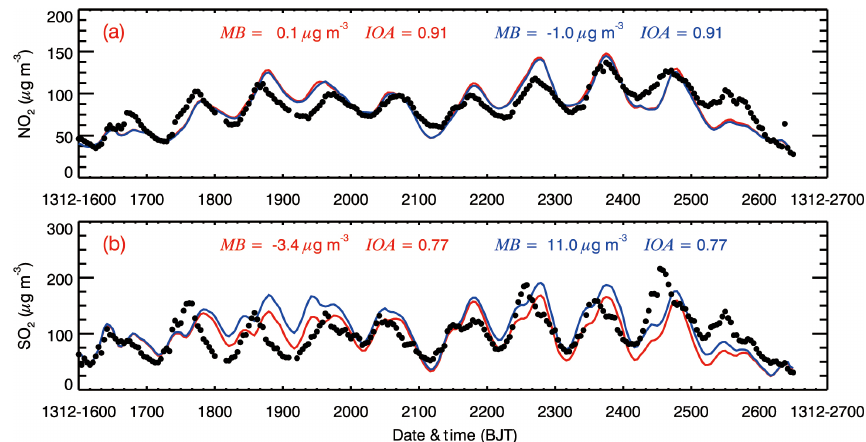
Figure 9. Comparison of measured and predicted diurnal profiles of near-surface hourly (a) NO 2 and (b) SO 2 averaged over all ambient monitoring sites in GZB from 16 to 27 December 2013. The black dots correspond to the observations, and the solid red and blue lines are the simulations in the E-case and B-case, respectively.